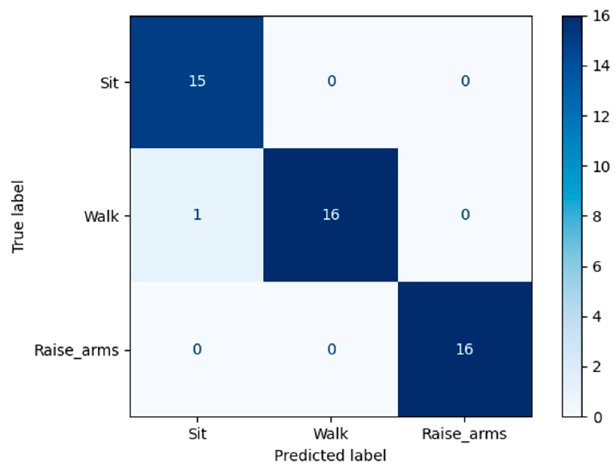
Figure 17. Confusion matrix results.